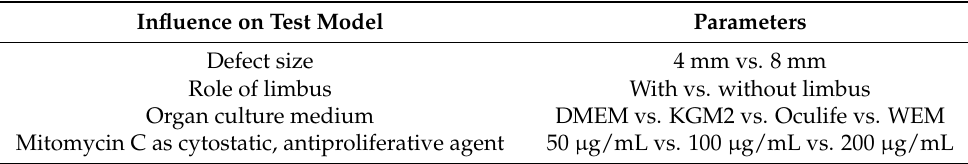
Table 2. Summary of parameters for optimization and evaluation of corneal organ